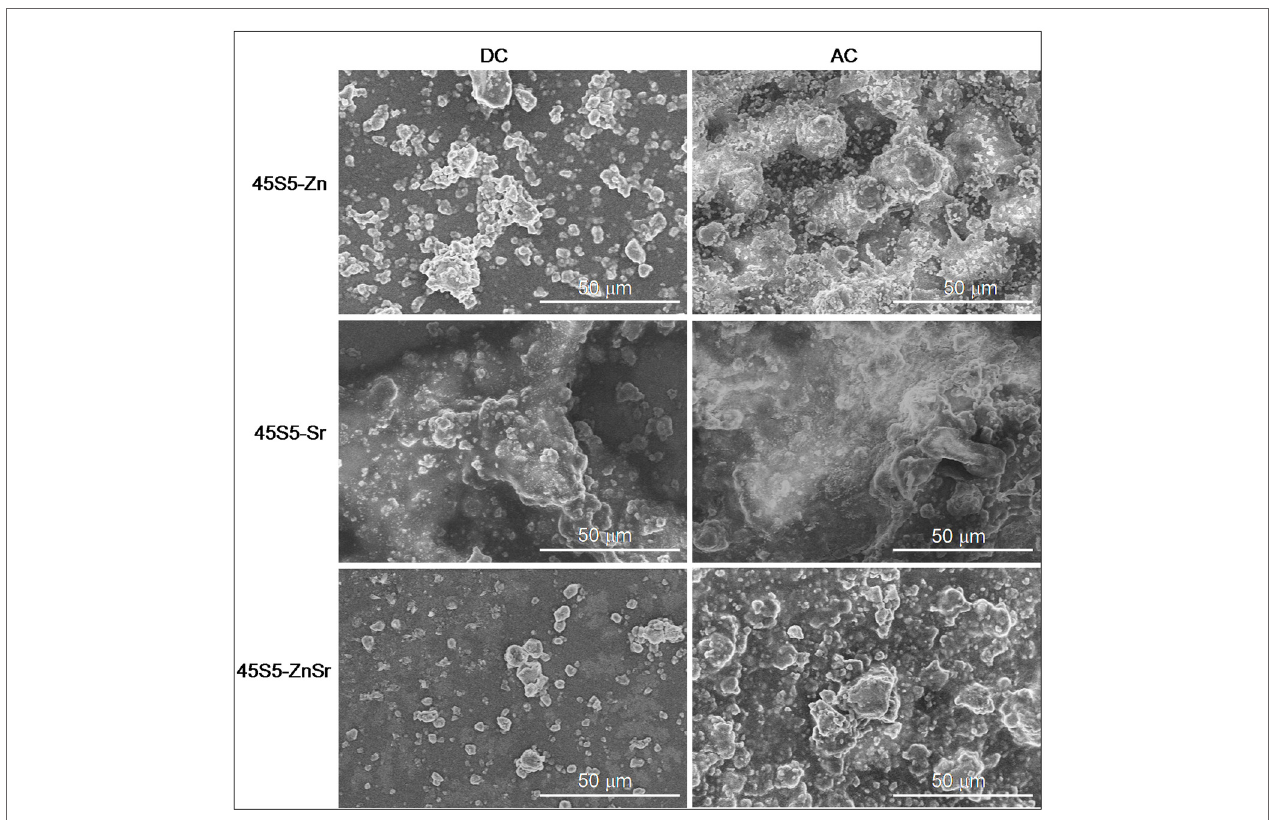
FigUre 8 | seM images of ac- and Dc-ePD-obtained coatings showing glass particles in chitosan matrix .